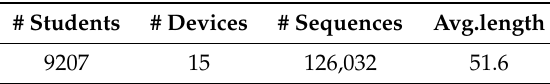
Table 7. The statistic of the resulted dataset.